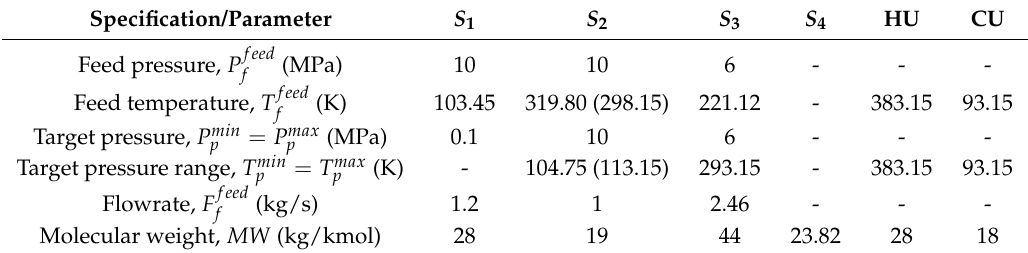
Table 2. Specification for process streams and utility streams (HU: hot utility; CU: cold utility).